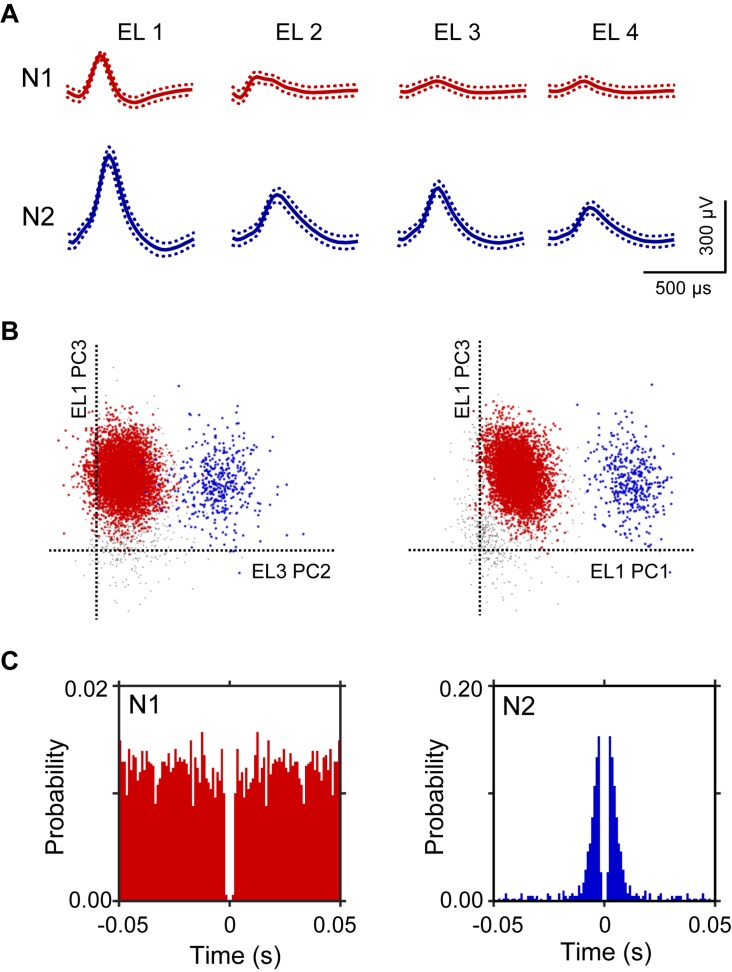
An example of an offline spike sorting. (A) Waveforms (mean ± standard deviation, indicated by solid and dotted lines, respectively) recorded from four electrodes (tetrode; EL 1–4). The N1 (red) and N2 (blue) waveforms correspond to two individual neurons, identified by offline spike sorting in B. (B) Results of offline spike sorting. Each axis represents a principle component (PC1-3). Each dot represents one neuronal spike. Semi-automatic spike sorting resulted in two clusters of neuronal signals (red and blue dots, corresponding to N1 and N2 in A, respectively). Gray dots represent unsorted spikes. (C) Autocorrelograms of the neurons. Bin width = 1 ms. Ordinates indicate probability, where bin counts were divided by the number of spikes in the spike train.